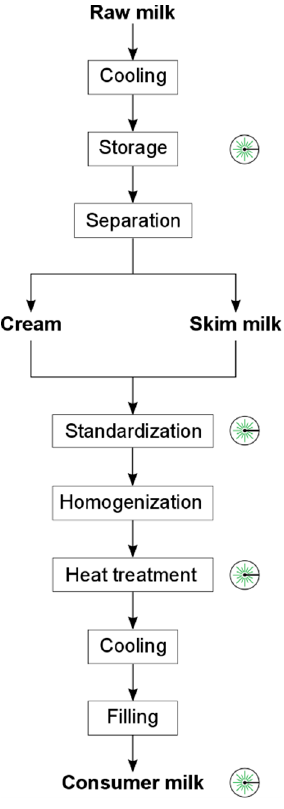
Figure 1. General production scheme of consumer milk and control points.